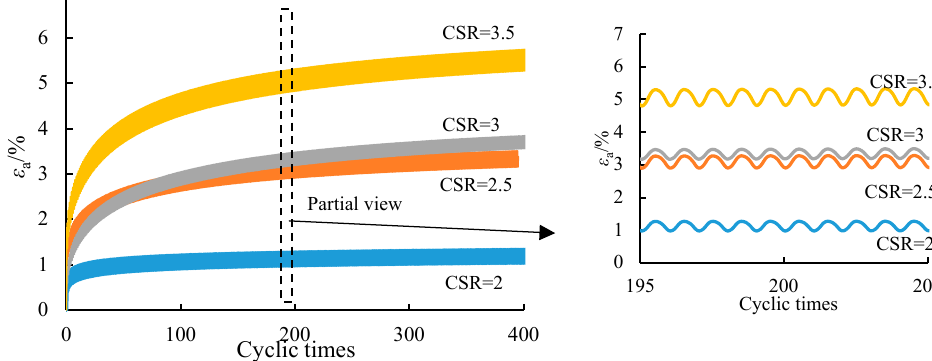
Figure 5. Axial cumulative strain curve of soil samples with various CSR at 100 kPa confining pressure.